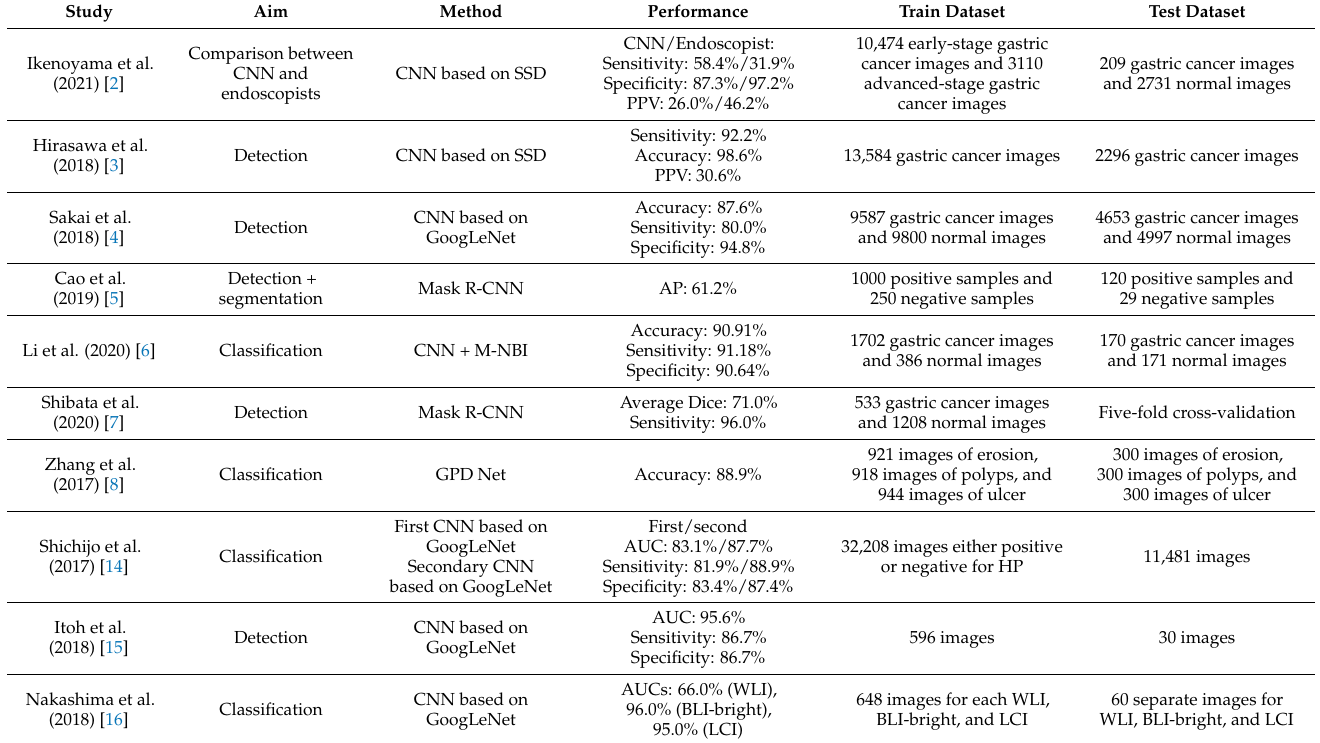
Table 1. Characteristics of models for the diagnosis of gastric cancer and Helicobacter pylori (HP) infection. Study Method Performance Train Dataset Test